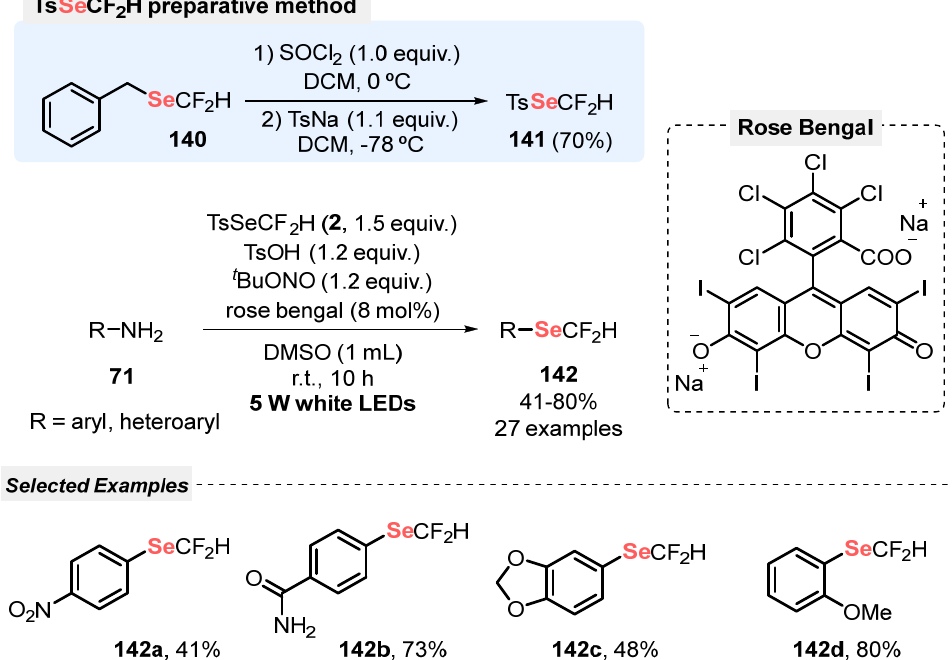
Scheme 78. Visible light ‐ promoted difluoromethylselenylation of arylamines 71 under metal ‐ free